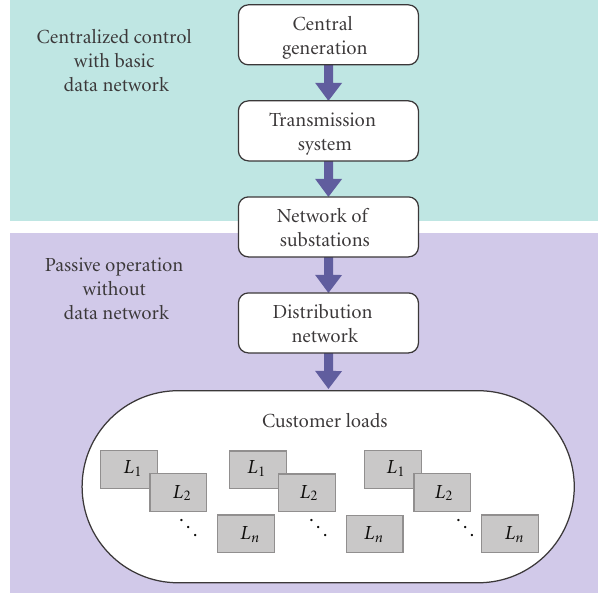
Figure 1: Structure of existing power grid.